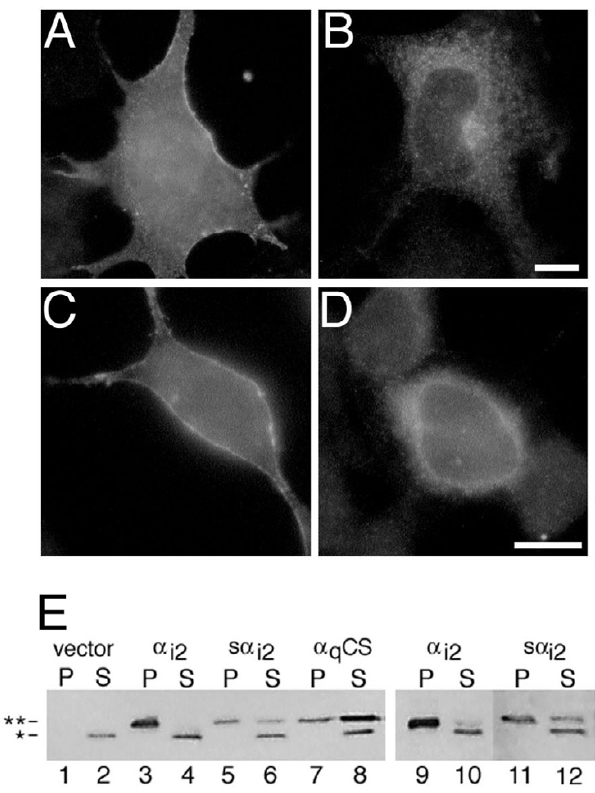
Figure 2 Localization of α i2 and s α i2 Expression vectors encoding α α i2 (A and C) or s i2 (B and D) were transiently transfected into COS-7 (A and B) or BHK (C and D) cells. Subcellular localization of the proteins was visualized by immunofluores- cence microscopy using the EE monoclonal antibody fol- lowed by a Texas Red conjugated anti-mouse antibody, as described in "Materials and Methods". Bar, 10 µ m. E,